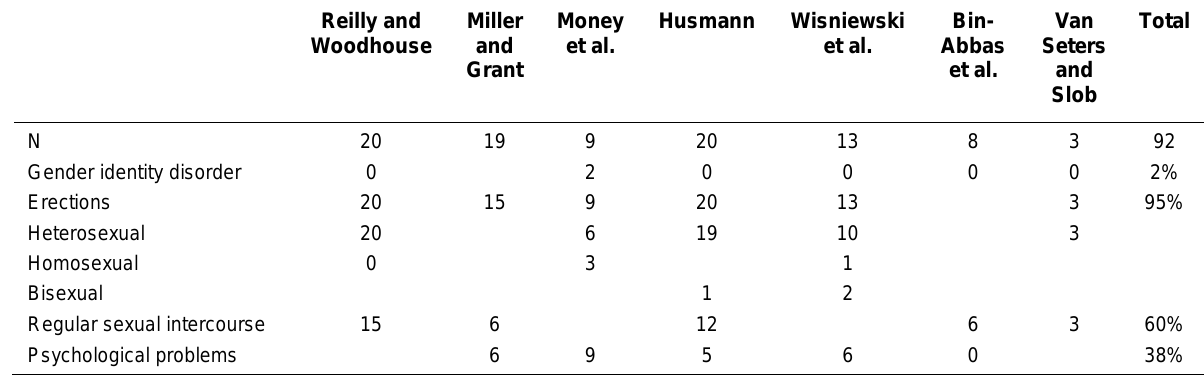
Sexual Function with a Small Penis Reilly and Miller Money Woodhouse and et al. Grant